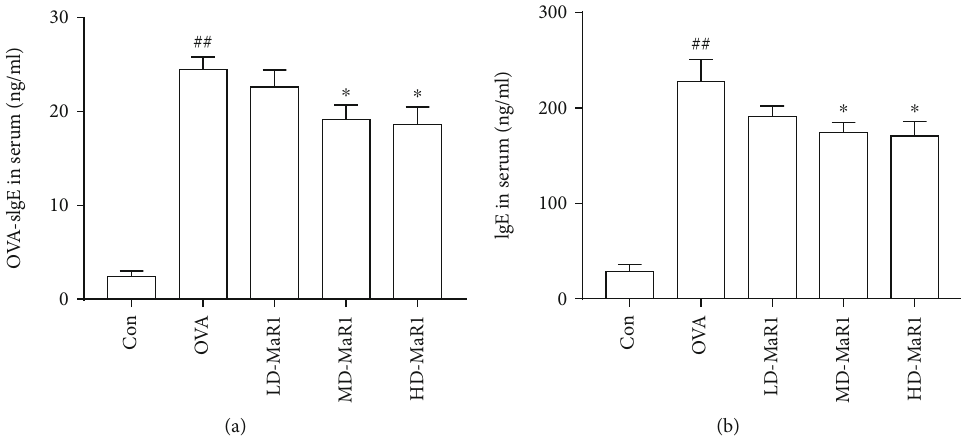
Figure 5: The mice were sacri fi ced 24 hours after the last OVA aerosol challenge; blood was taken by cardiac puncture and serum was collected. (a) OVA-speci fi c IgE level in serum. (b) IgE level in serum. Data expressed as mean ± SEM ( n = 6/group ). # P < 0 : 05 , ## P < 0 : 01 vs. the control group; ∗ P < 0 : 05 , ∗∗ P < 0 : 01 vs. OVA.